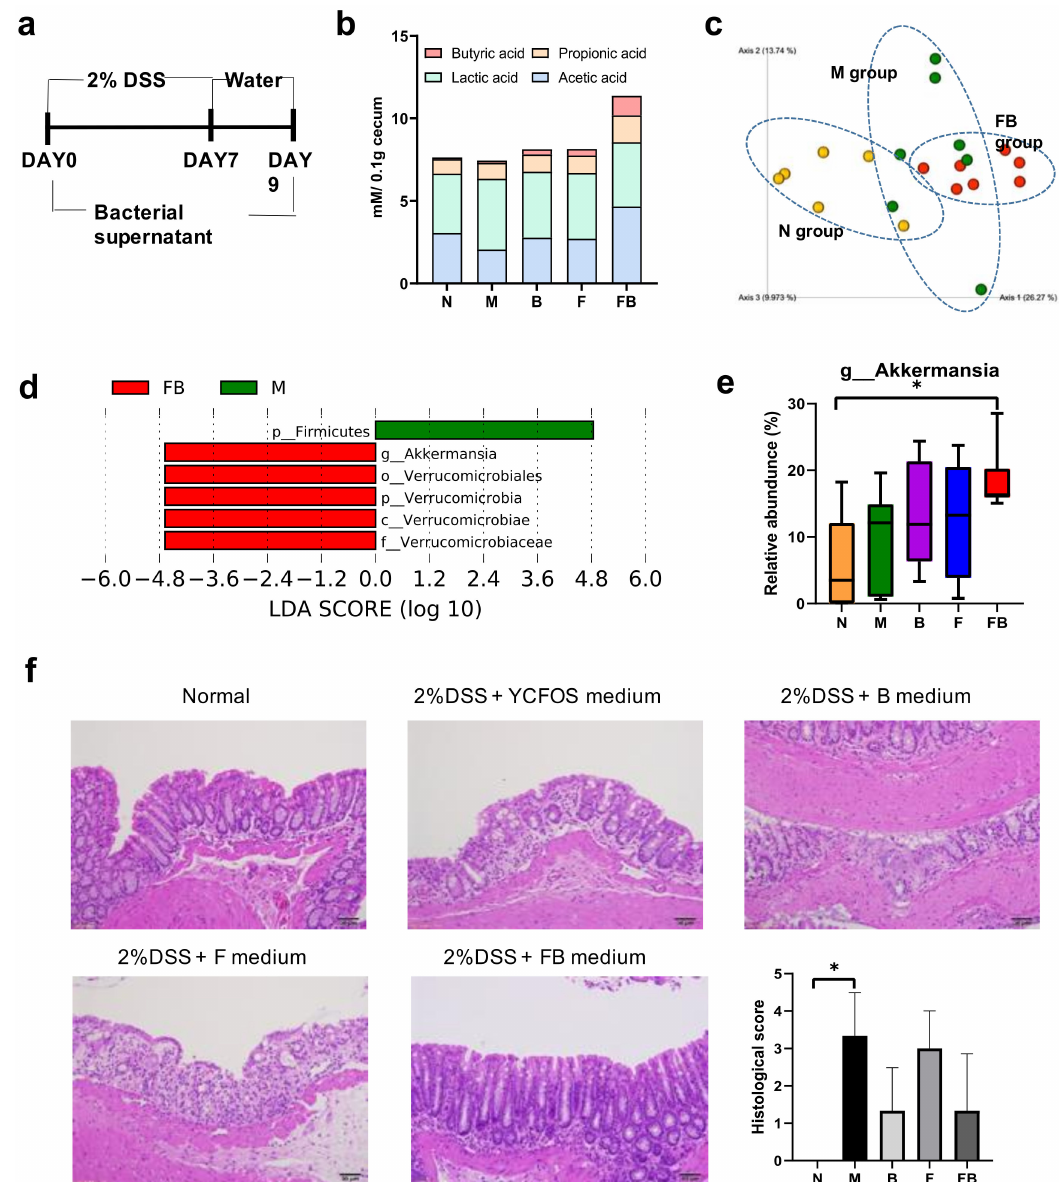
Figure 6. E ff ect of supernatant from bacterial co-culture on DSS-induced colitis in a mouse model. Colitis was induced in mice by feeding 2% ( w / v ) DSS for 7 d; the mice were concomitantly administered bacterial supernatant ( a ). The SCFA levels and microbiome were analyzed in mouse cecum samples (6 mice per group). The levels of butyrate, propionate, lactate, and acetate in the cecum are shown in ( b ). The beta-diversity based on the Bray-Curtis distance is shown in ( c ). Significantly di ff erent taxa in the FB (red) and M (green) groups were identified by LEfSe analysis (threshold > 2.0), as shown in ( d ). Relative abundance of the genus Akkermansia is shown in ( e ). Histopathological changes in the colon are presented in ( f ). Representative H&E-stained colon sections are shown for each group, × 50 magnification, with the histological scores. The data are shown as the mean ± standard deviation ( n = 6). Statistically significant di ff erences vs. untreated mice (* p < 0.05). N, untreated mice; M, DSS-induced colitis mice administered culture medium control; FB, DSS-induced colitis mice administered with medium from F. prausnitzii and B. catenulatum co-culture; F, DSS-induced colitis mice administered with medium from F. prausnitzii culture; B, DSS-induced colitis mice administered with medium from B. catenulatum